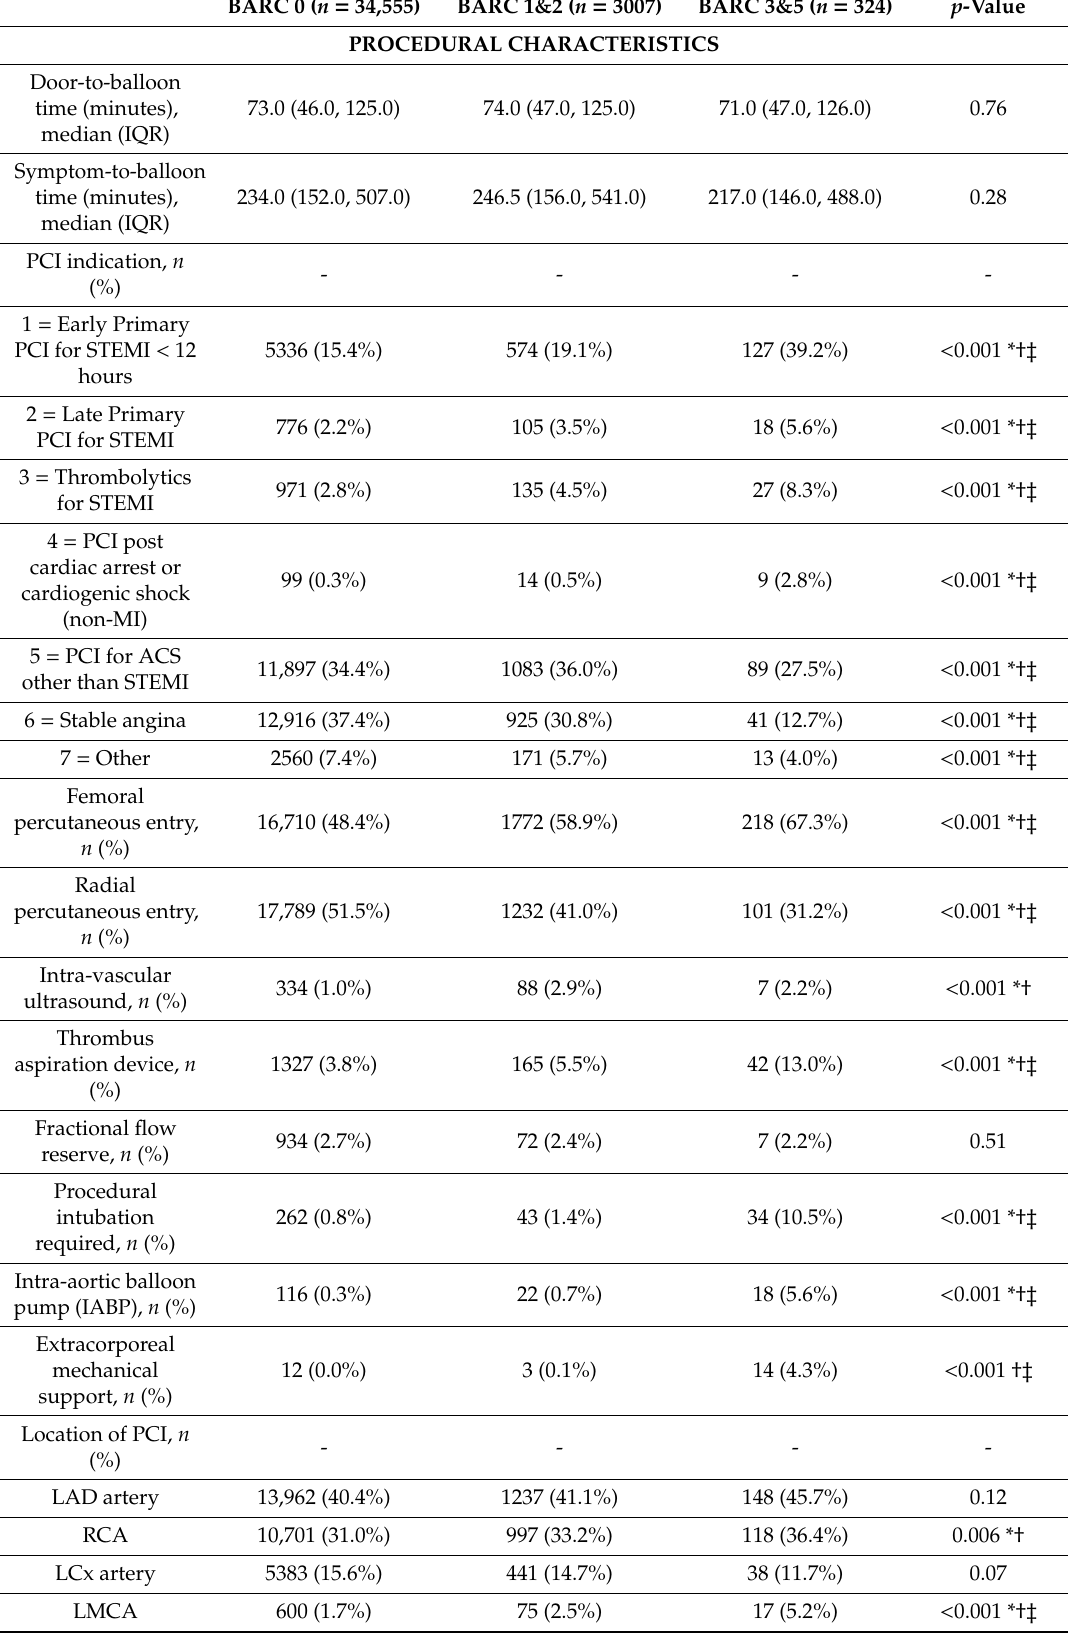
Table 2. Baseline procedural